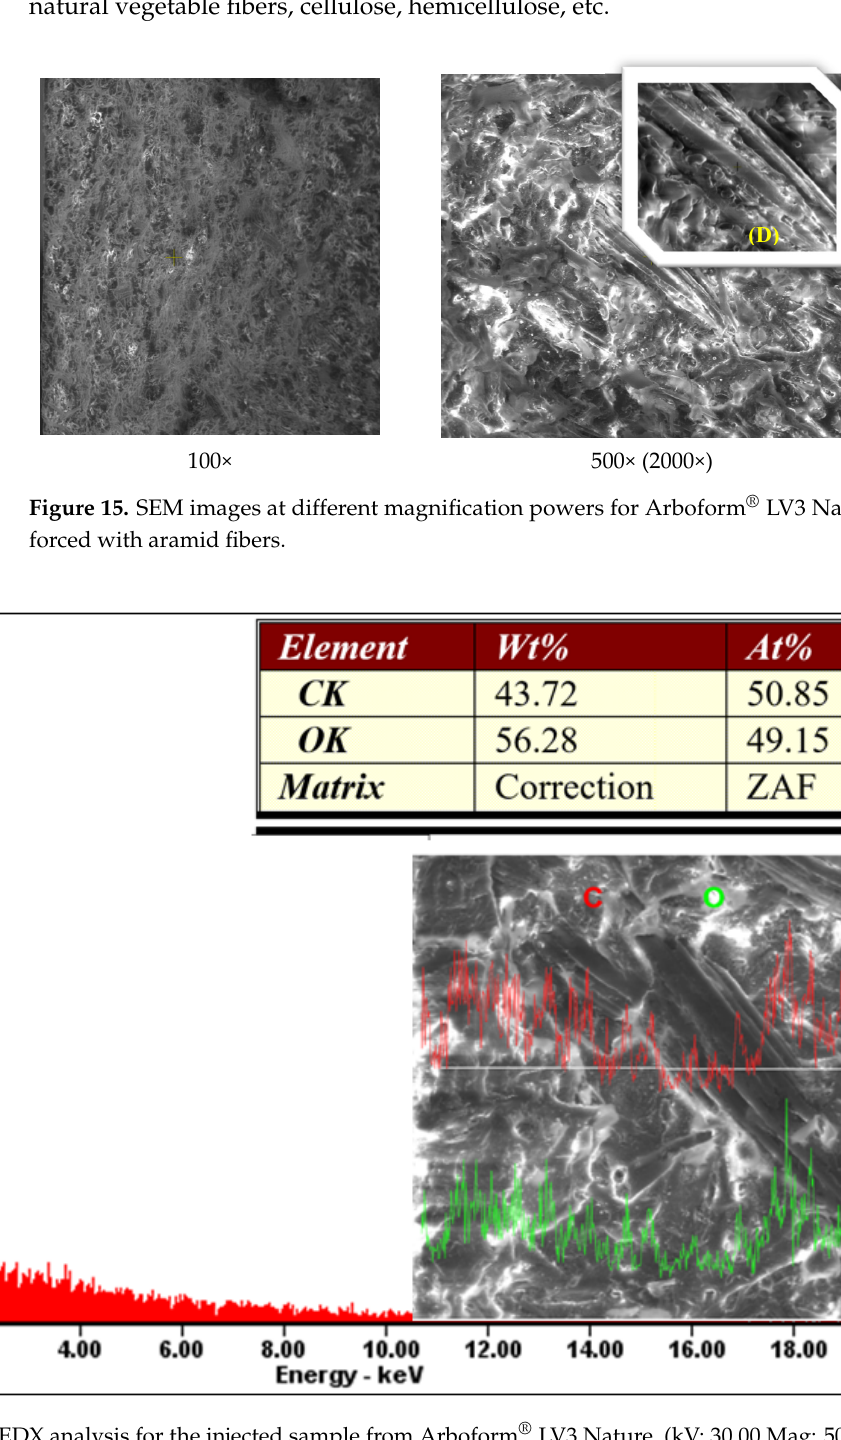
Figure 16. In-line EDX analysis for the injected sample from Arboform ® LV3 Nature, (kV: 30.00 Mag: 500x). The sample from Arboform ® LV3 Nature, reinforced with aramid fibers (synthetic),